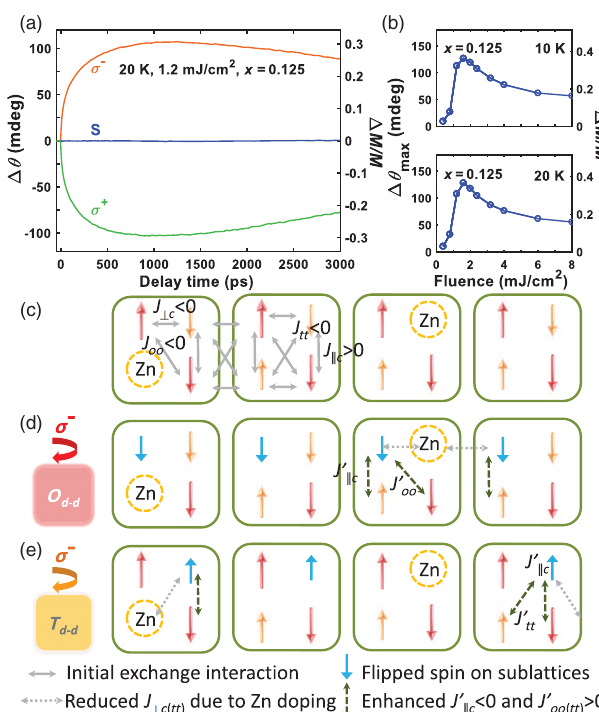
FIG. 5. (a) Large Kerr rotation developed for x ¼ 0 . 125 with a circularly polarized pump from O . (b) Nearly identical fluence d - d dependence for the maximum TRMOKE signal at 10 and 20 K. In both (a) and (b), the left axis displays the photoinduced Kerr rotation angle, whereas the right axis shows the ratio of photo- induced magnetization to the saturated magnetization. (c) Four magnetic bases are displayed to show the homogeneous Zn substitution for the x ¼ 0 . 125 sample. The exchange couplings are depicted with gray double arrows in the first two bases. (d),(e) Excited states for O and T . The removal of the AFM d - d d - d coupling between the intralayer (interlayer) O - T ( T - T ) interac- tion for O ( T ) is indicated by the dotted gray double arrows. d - d d - d The altered exchange interaction J 0 after excitations is displayed ij in dashed green double arrows. The stabilization after circularly polarized photoexcitation, σ − here, can be achieved through these modulations of exchange interactions (see text for a detailed